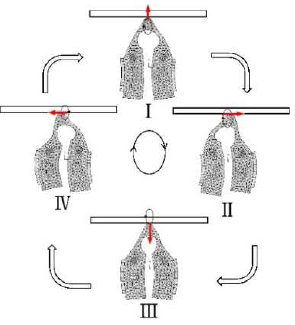
Figure 4. Stator actuation cycle.